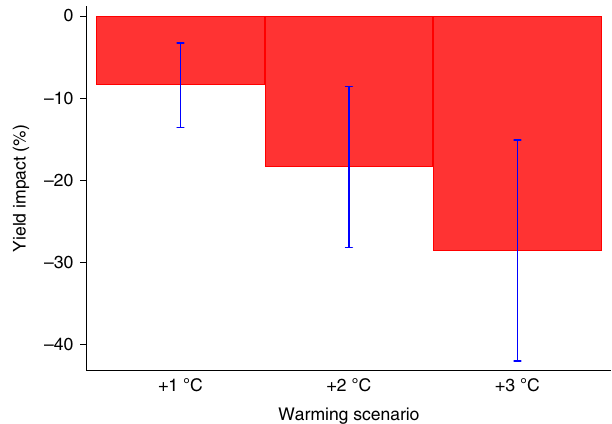
Fig. 3 Wheat yield impacts by + 1 to + 3 °C warming scenarios. Impacts are reported as the percentage change in mean yield relative to historical climate. The graph displays the warming impacts under our preferred model for uniform warming scenarios from + 1 to + 3 °C. Bars show 95% con fi dence intervals using standard errors clustered by province-year for n = 18,881 yield observations. Results from a uniform warming scenario of + 1 °C show an average wheat yield reduction of 8.5% (Delta Method = − 3.21, p = 0.001), which increases to 18.4% (Delta Method = − 3.68, p = 0.000) and 28.5% (Delta Method = − 4.16, p = 0.000) under + 2 and + 3 °